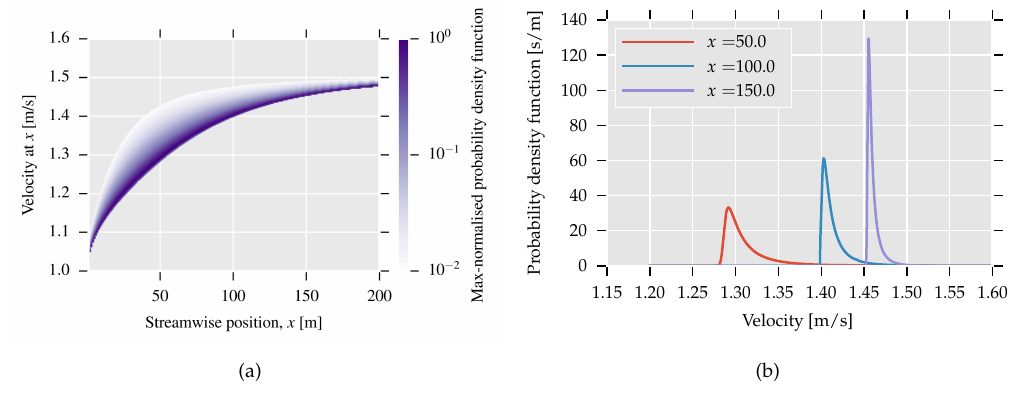
Figure 5. ( a ) PDFs as a function of streamwise position. PDF for each x is normalised with respect to its maximum value; ( b ) PDFs for three selected